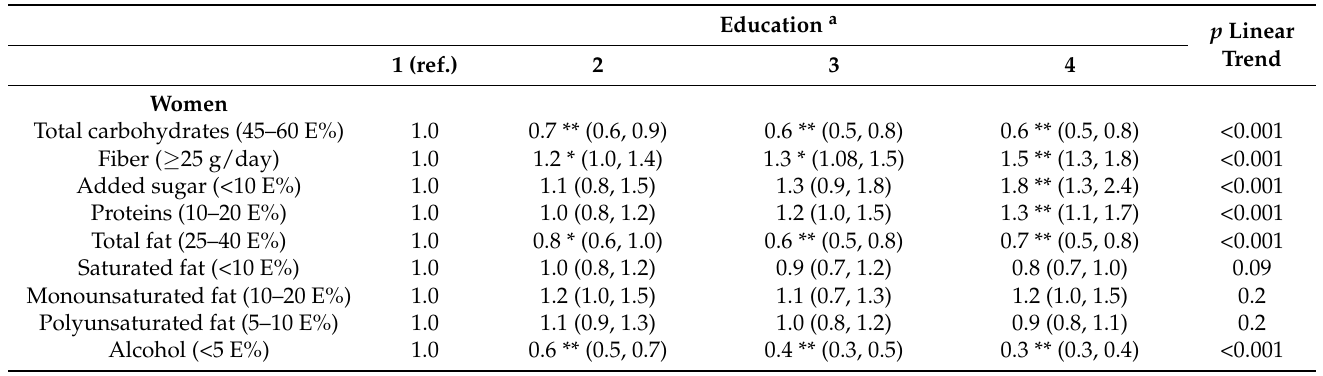
Table 4. Adjusted odds of compliance with the Nordic Nutrition Recommendations 2012. The Tromsø Study 2015–2016. Education a p